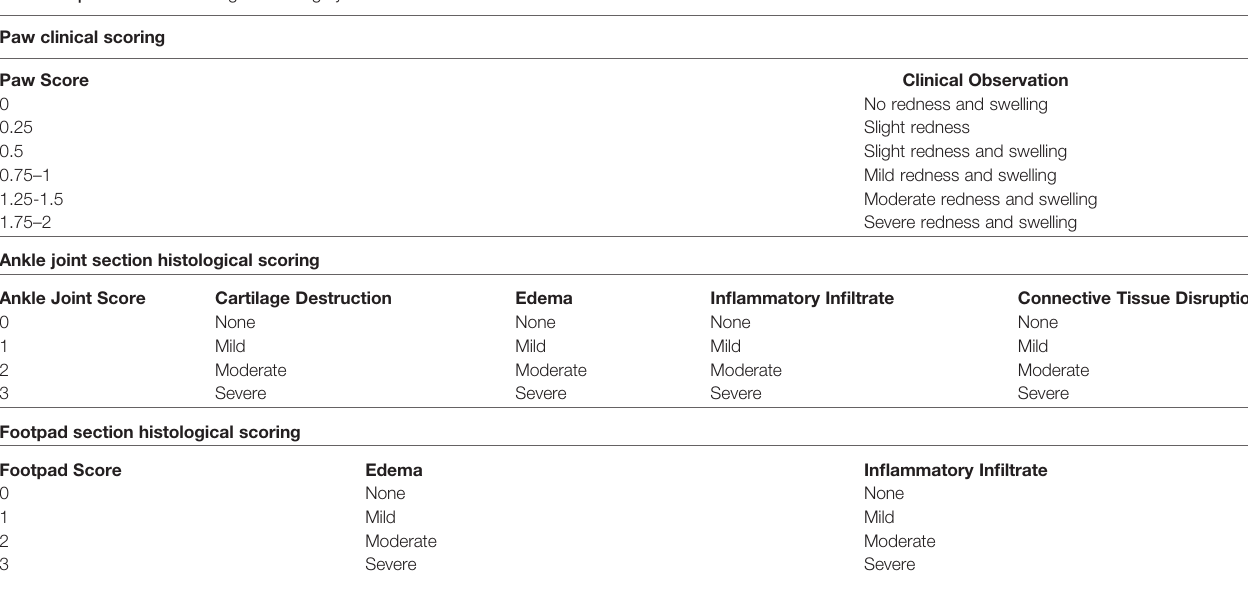
TABLE 1 | Clinical and histological scoring systems for arthritic C57BL/6J mice. Paw clinical scoring Paw